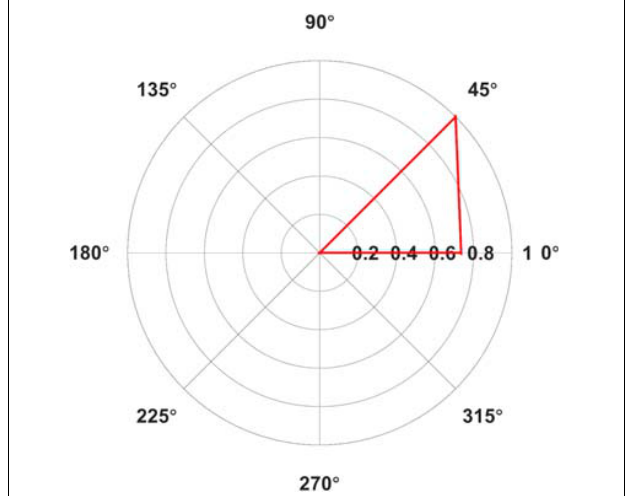
FIGURE 4 | Polar plot of average Area Under the Curve (AUC) elicited from contralateral (A) First Dorsal Interosseous (FDI) in mV · ms for Middle Latency MEPs only. Only average values with > 5 contributing subjects are included. Values normalized relative to the largest value, set to